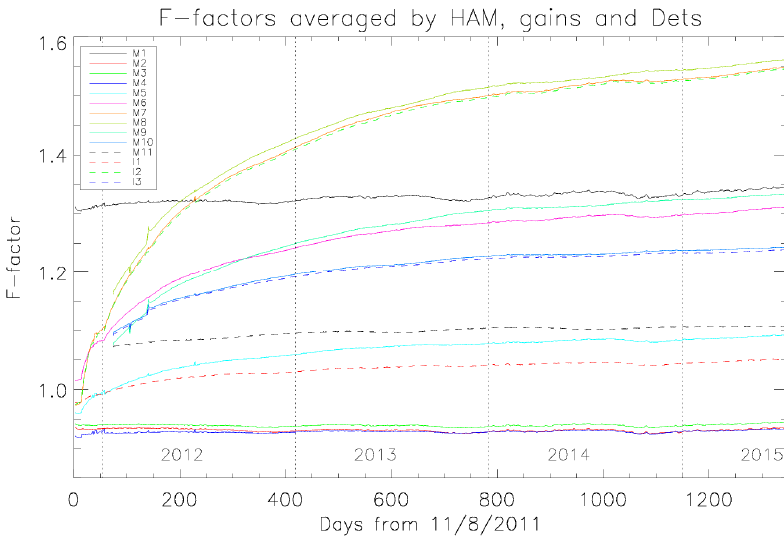
Figure 2. NOAA ICVS VIIRS F-factors averaged in Half Angle Mirror (HAM) sides, gain states and detectors for all the RSB bands. detectors for all the RSB